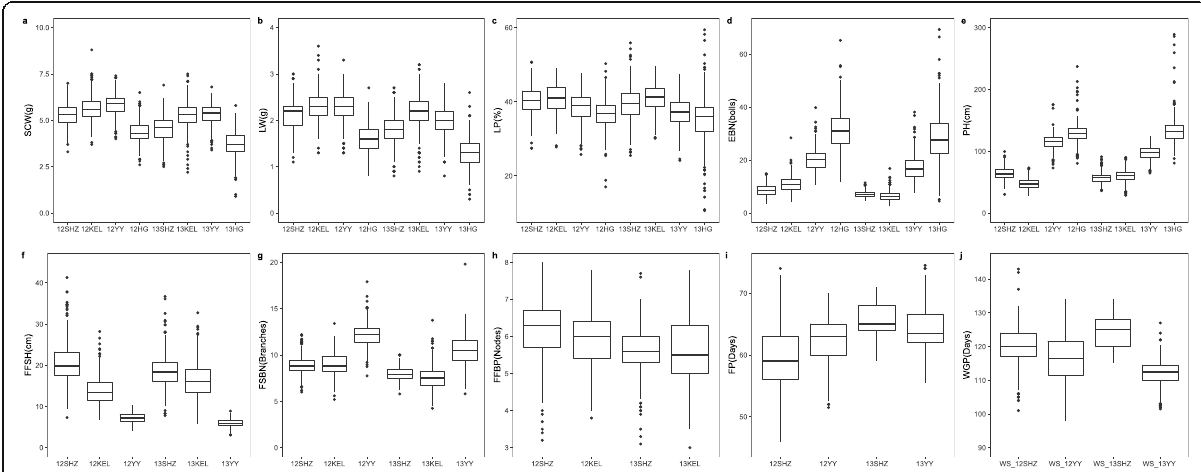
Fig. 1 The boxplots of the changing trends of ten yield-related traits in multiple environments. 12SHZ (Shihezi in 2012), 12KEL (Kuerle in 2012), 12YY (Yuanyang in 2012), 12HG (Huanggang in 2012), 13SHZ (Shihezi in 2013), 13KEL (Kuerle in 2013), 13YY (Yuanyang in 2013), 13HG (Huanggang in 2013)